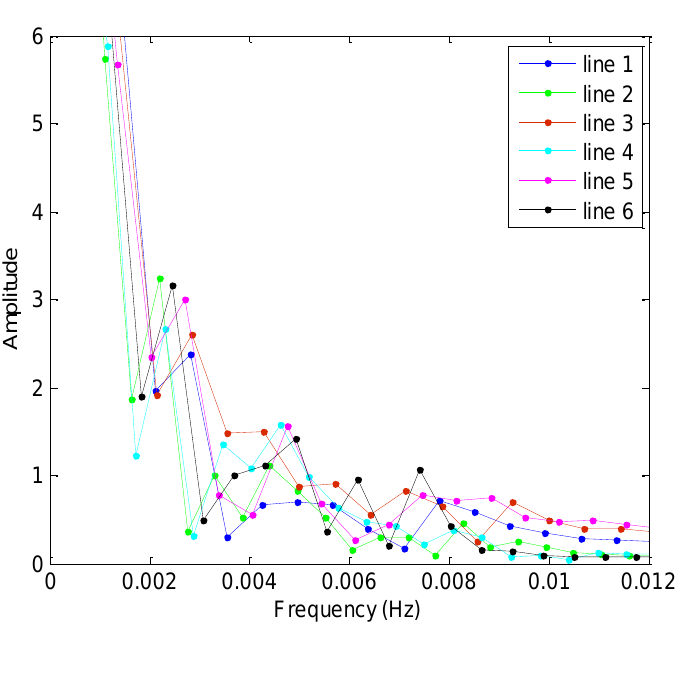
Figure 9. Amplitude spectrum curves of